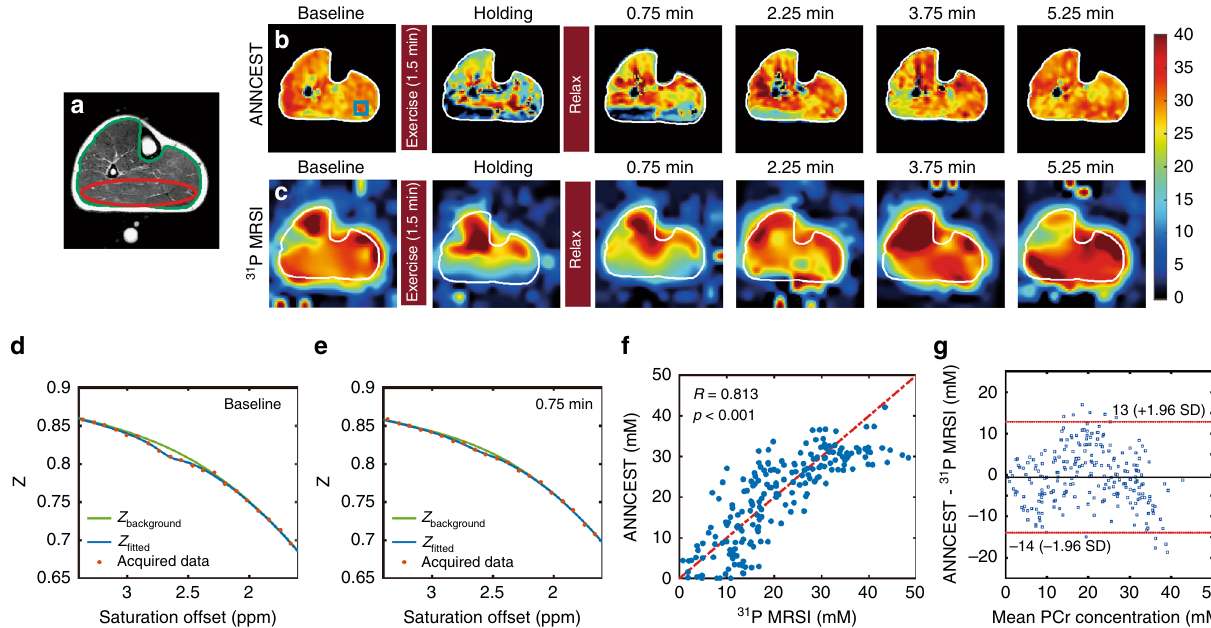
Fig. 5 Representative PCr maps of human skeletal muscle pre and post in-magnet plantar fl exion exercise using 31 P 2D MRS and ANNCEST methods. a T 2 -weighted anatomy image. PCr concentration maps obtained by b ANNCEST and c 31 P 2D MRS during the whole exercise process. The Z spectrum at baseline ( d ) and post exercise ( e ) extracted from the blue rectangle region shown in b . f The correlation analysis of ANNCEST and 31 P 2D MRS from the red ellipse region shown in a for all four subjects ( n = 202 voxels). g Bland – Altman plot for the PCr concentrations obtained by ANNCEST and 31 P 2D